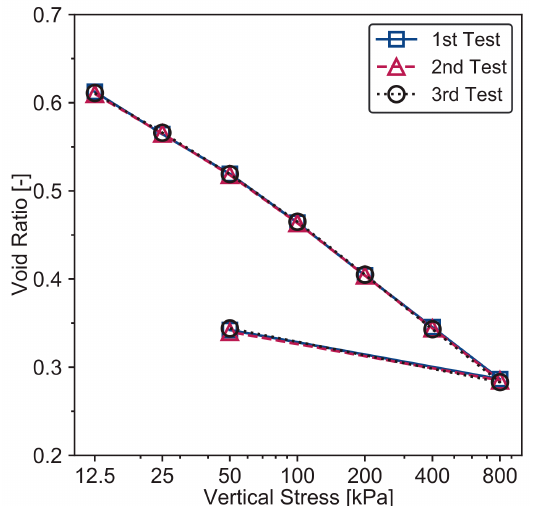
Figure 9. Void ratio as a function of vertical stress during oedometer tests.